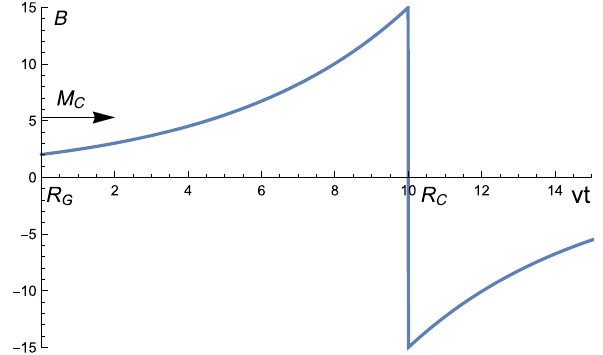
Fig. 6 Representation of the time evolution of the magnetic field seen by the monopolium